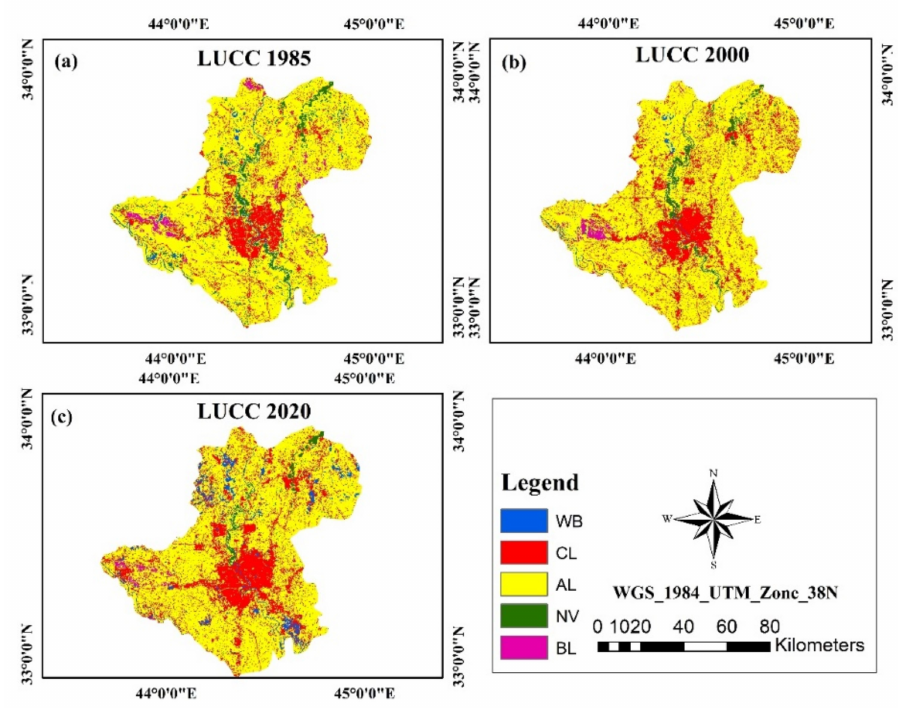
Figure 5. LUCC classification from 1985 to 2020. ( a ) LUCC 1985, ( b ) LUCC 2000, ( c ) LUCC 2020. In accordance with the LUCC analysis, AL covers the largest area accounting for 5737.45 km 2 , urban CL is the second largest, which covered 1183.66 km 2 , and the smallest one is WB accounting for 167 km 2 in 1985. With the fastest increase in Baghdad’s population between 1950 to 2020 from 579,167 to 7,144,260 (Figure 2) [49], the highest rate of increase is found between 1958 to 1965, and the population increase rate reached from 8.14% to 9.66%. The decreasing rate of the Baghdad population is between 2004 and 2007 from − 2.59% to − 2.60%. The population has a high-speed increasing rate, continuously increases,